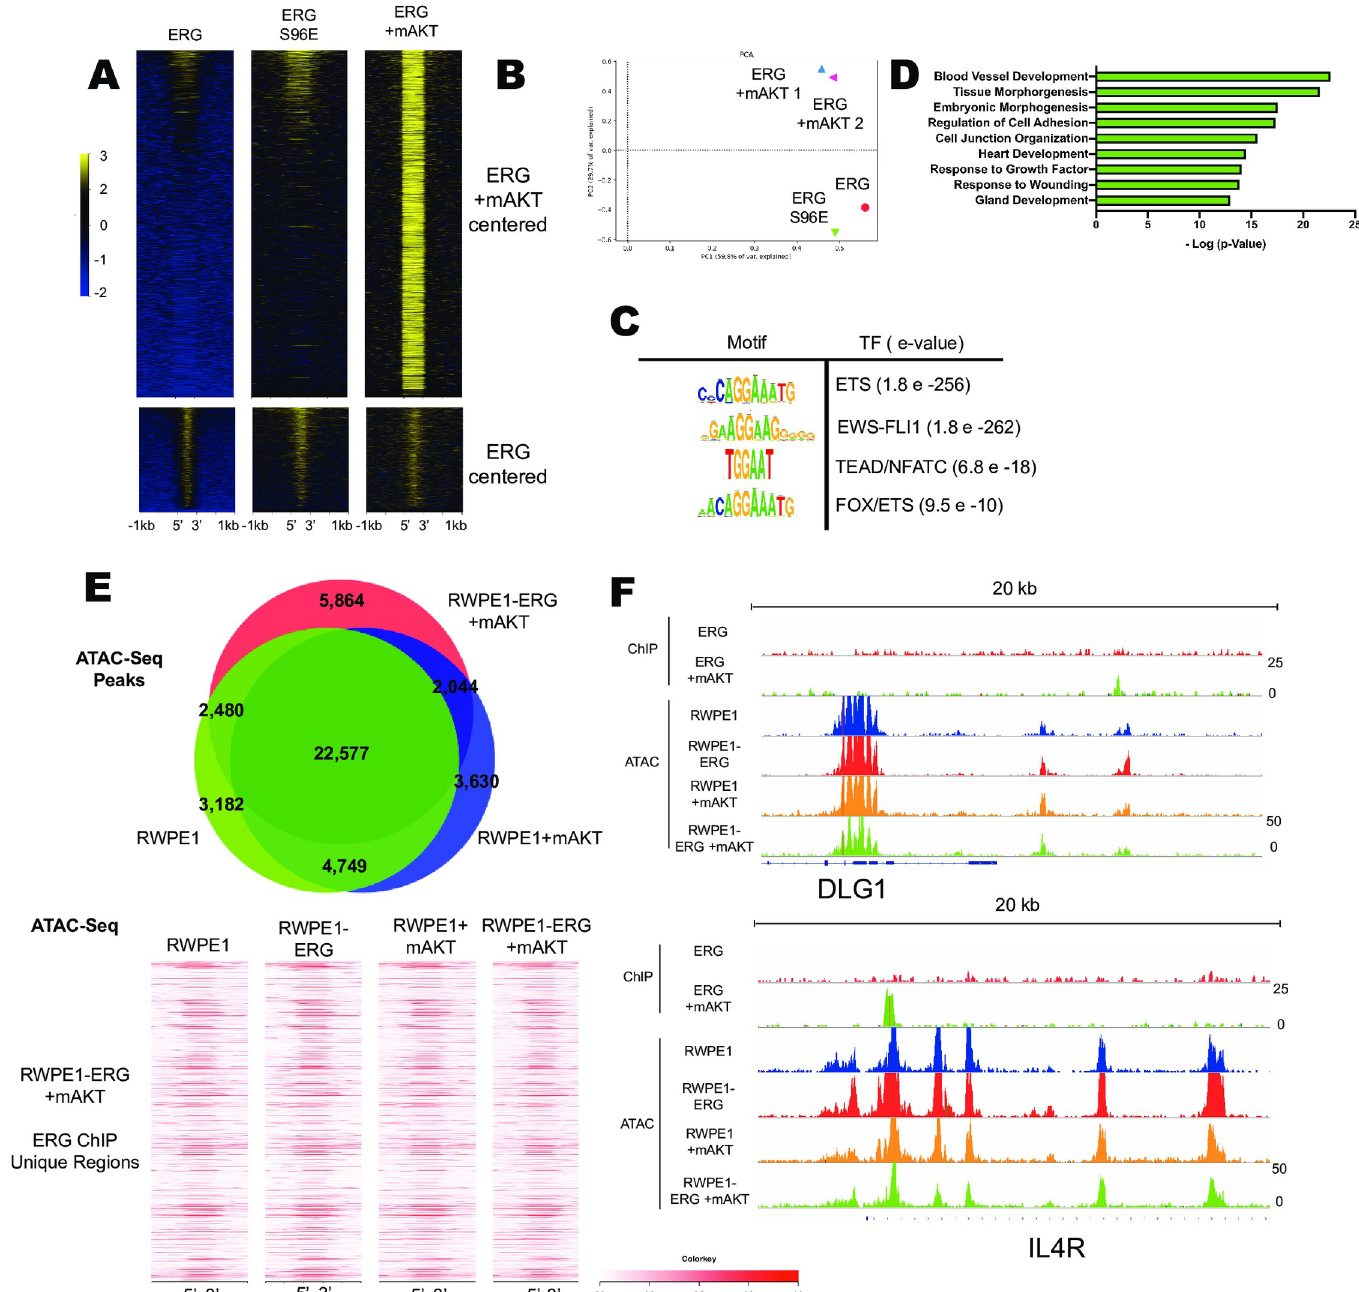
Fig 4. Constitutive PI3K/AKT signaling allows new ERG binding across the genome. (A) ChIP-Seq of ERG in RWPE1 cell lines centered on called peaks in RWPE1-ERG/mAKT cell line (top) and centered on peaks called in RWPE1-ERG cells (bottom) (B) PCA analysis of ERG ChIP-Seq with two biological replicates from RWPE-ERG/mAKT. (C) Motif and (D) Gene Ontology analysis of ERG called peaks in RWPE1-ERG/mAKT cells. (E) Overlap of the top 33,000 ATAC-Seq peaks from RWPE1, RWPE1+mAKT, and RWPE1-ERG/mAKT cells and heatmap of ATAC-Seq reads centered on unique peaks in ERG ChIP-Seq from RWPE1-ERG/mAKT cells. (F) Gene tracks of ERG ChIP-Seq and ATAC-Seq from RWPE1 cells depicting two representative regions bound by ERG only in